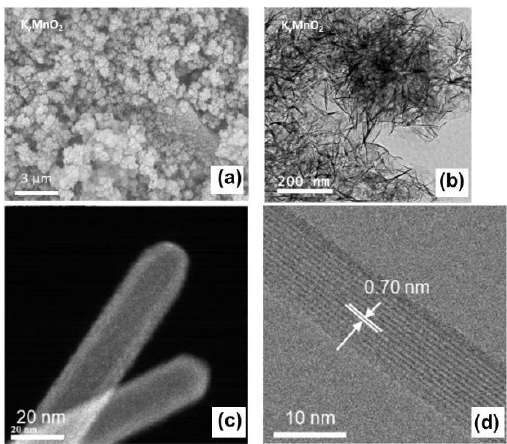
Figure 2. ( a ) SEM images of cryptomelane-type K y MnO 2 nanoneedles, ( b ) TEM image showing the interconnected nanoneedles and ( c , d ) HRTEM images. The lattice fringes (image ( c )) show an interplanar distance of 0.70 nm, which corresponds to the separation between the (110) crystal planes in the cryptomelane α -MnO 2